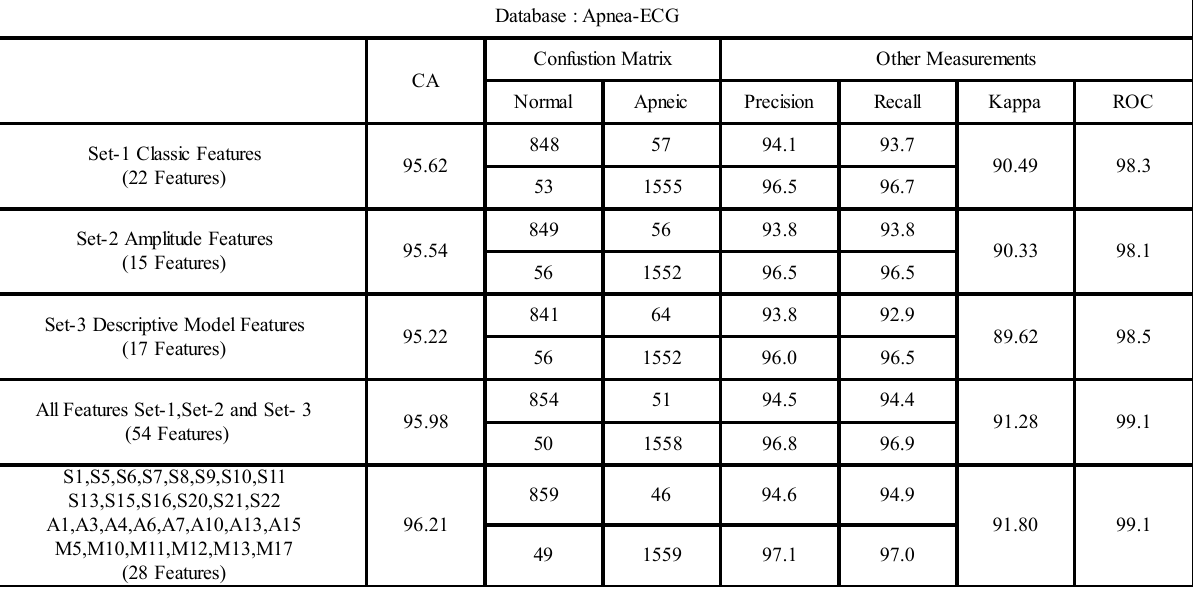
TABLE 4. CLASSIFICATION RESULTS OF FEATURES SETS FOR APNEA-ECG